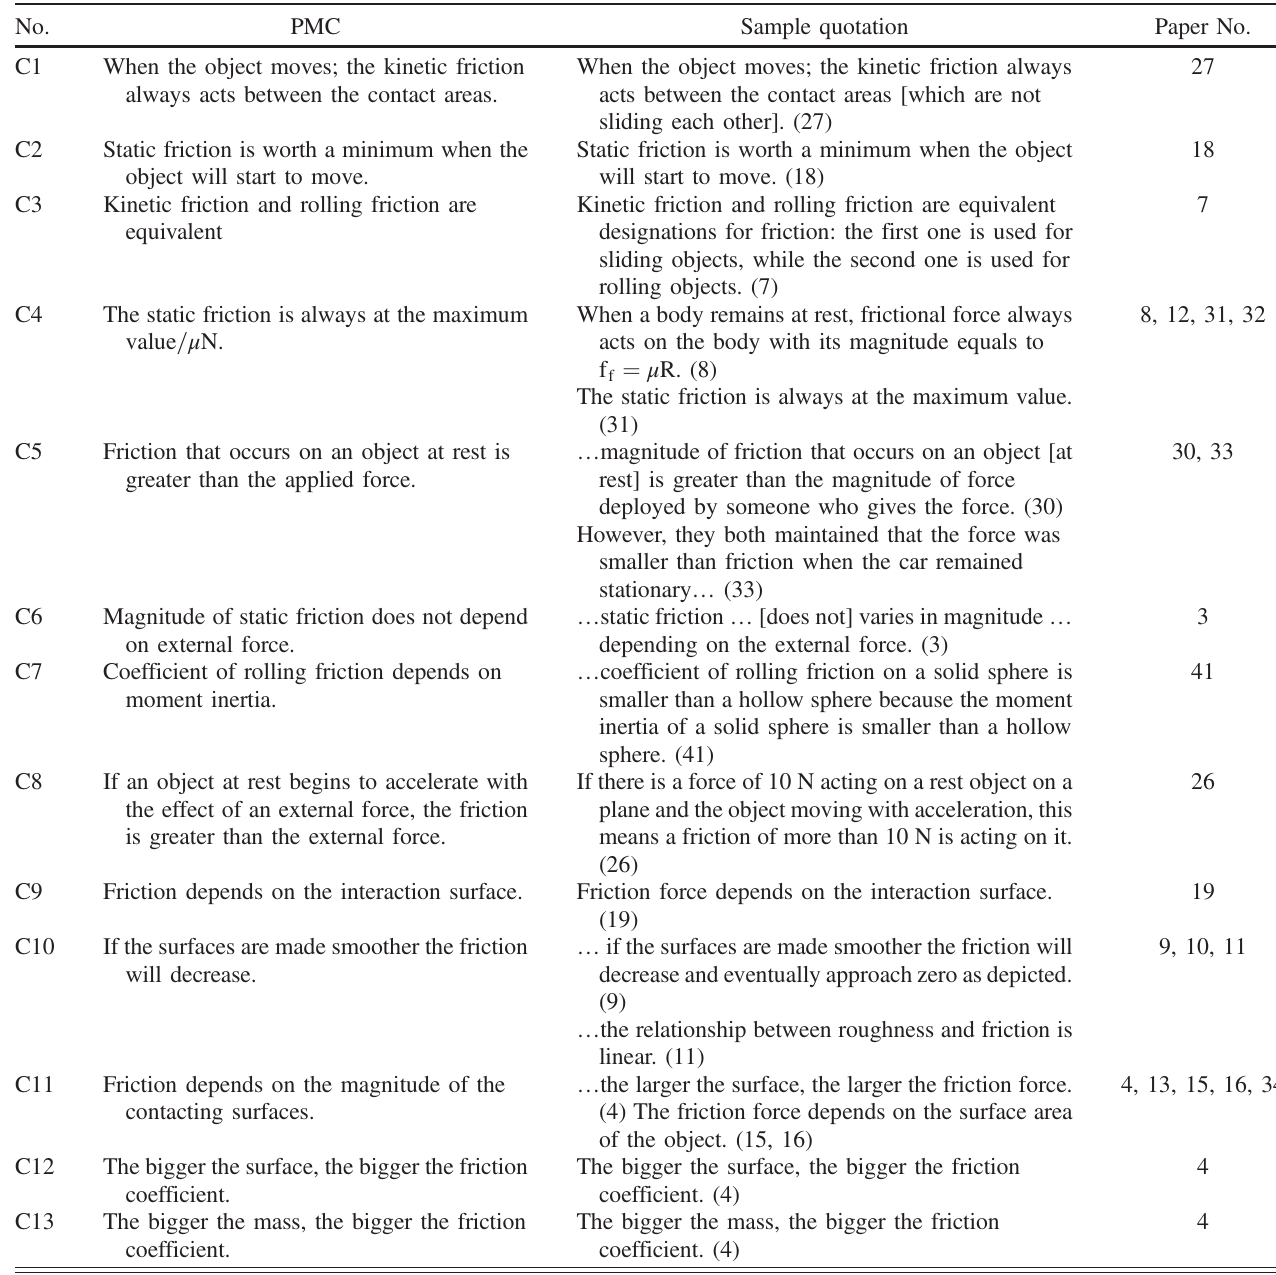
TABLE V. PMCs related to the type and magnitude of friction. No. PMC When the object moves; the kinetic friction always acts between the contact